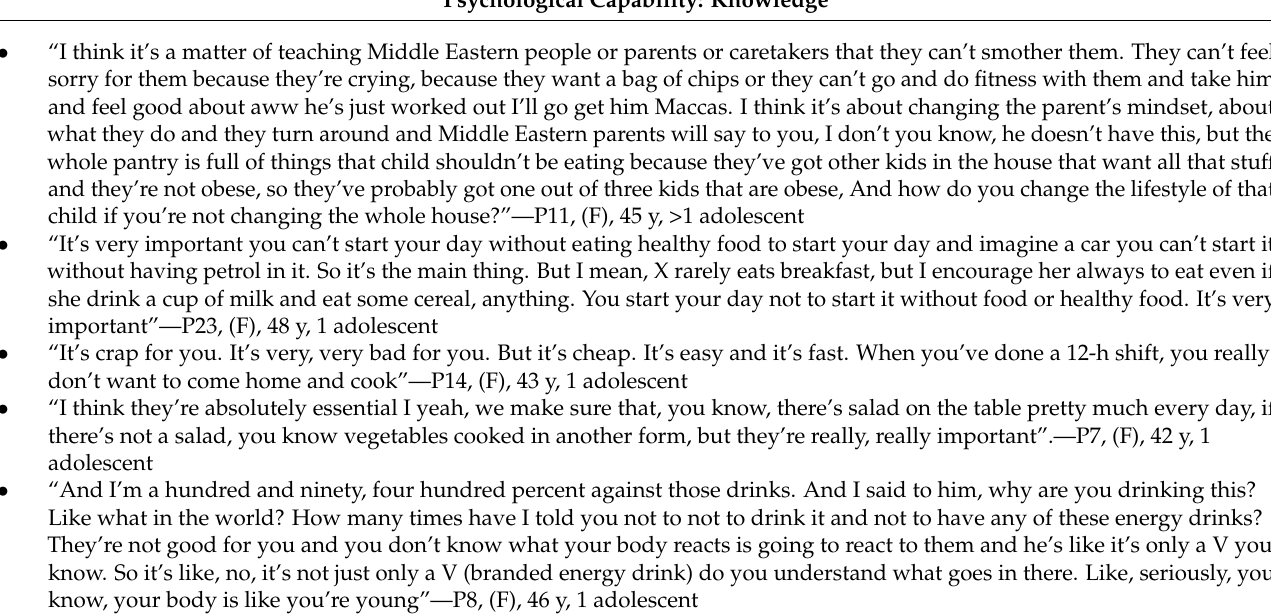
Table 3. Exemplary quotes from parents by key theme. Psychological Capability: